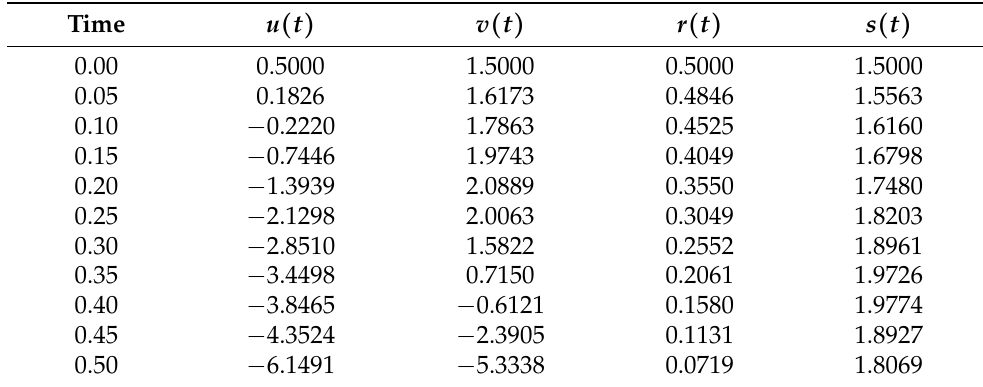
Figure 1. The solution of (4) at α = 0. Table 1. The solution of ( 4 ) at α =